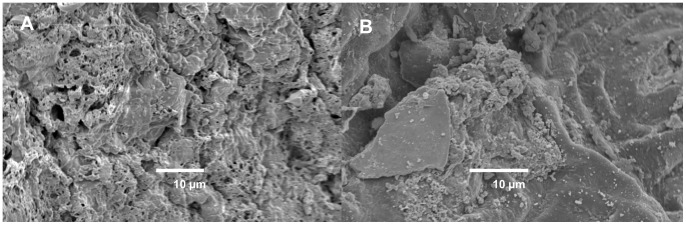
SEM images of waste tea powder (A) without and (B) with magnetite coating.